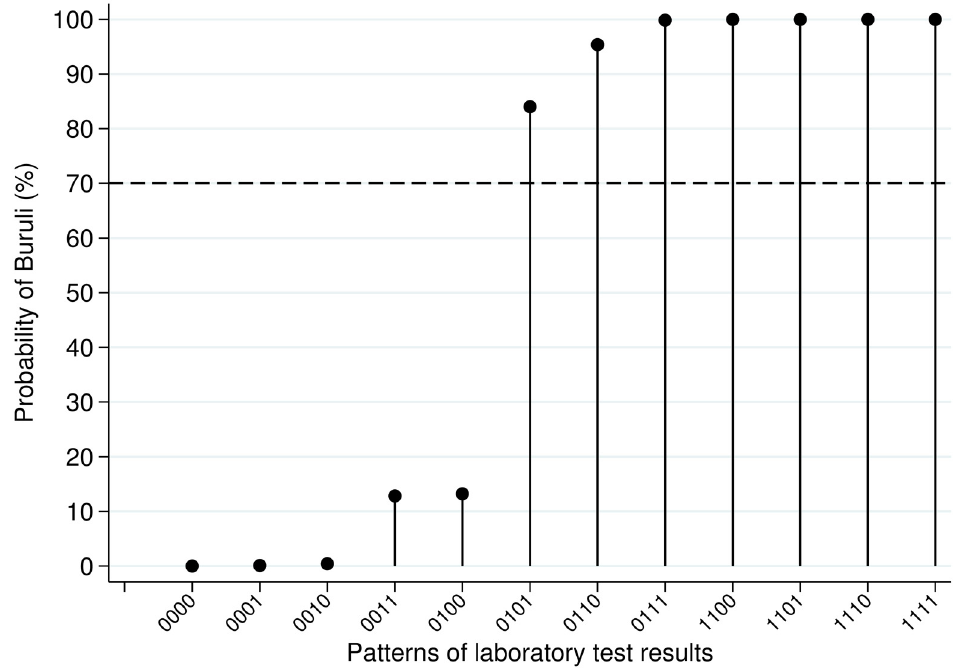
Fig 1. Estimated probability of Buruli ulcer according to pattern of laboratory test results in latent class model (1 = positive result, 0 = negative result; test order ZN CPC, PCR, culture, ZN Akonolinga. Dashed line: 70% probability of Buruli ulcer (predefined treatment